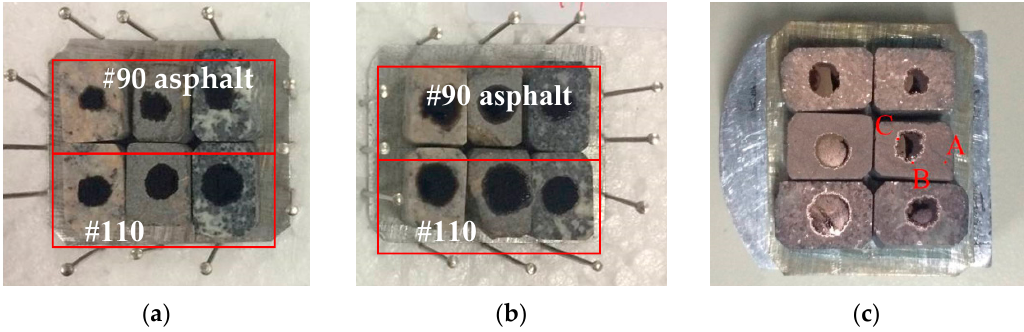
Figure 12. Specimens for scanning electron microscopy (SEM) with energy disperse spectroscopy (EDS) measurements: ( a ) control; ( b ) treated specimen; and ( c ) observation locations at one specimen (A, B, C).